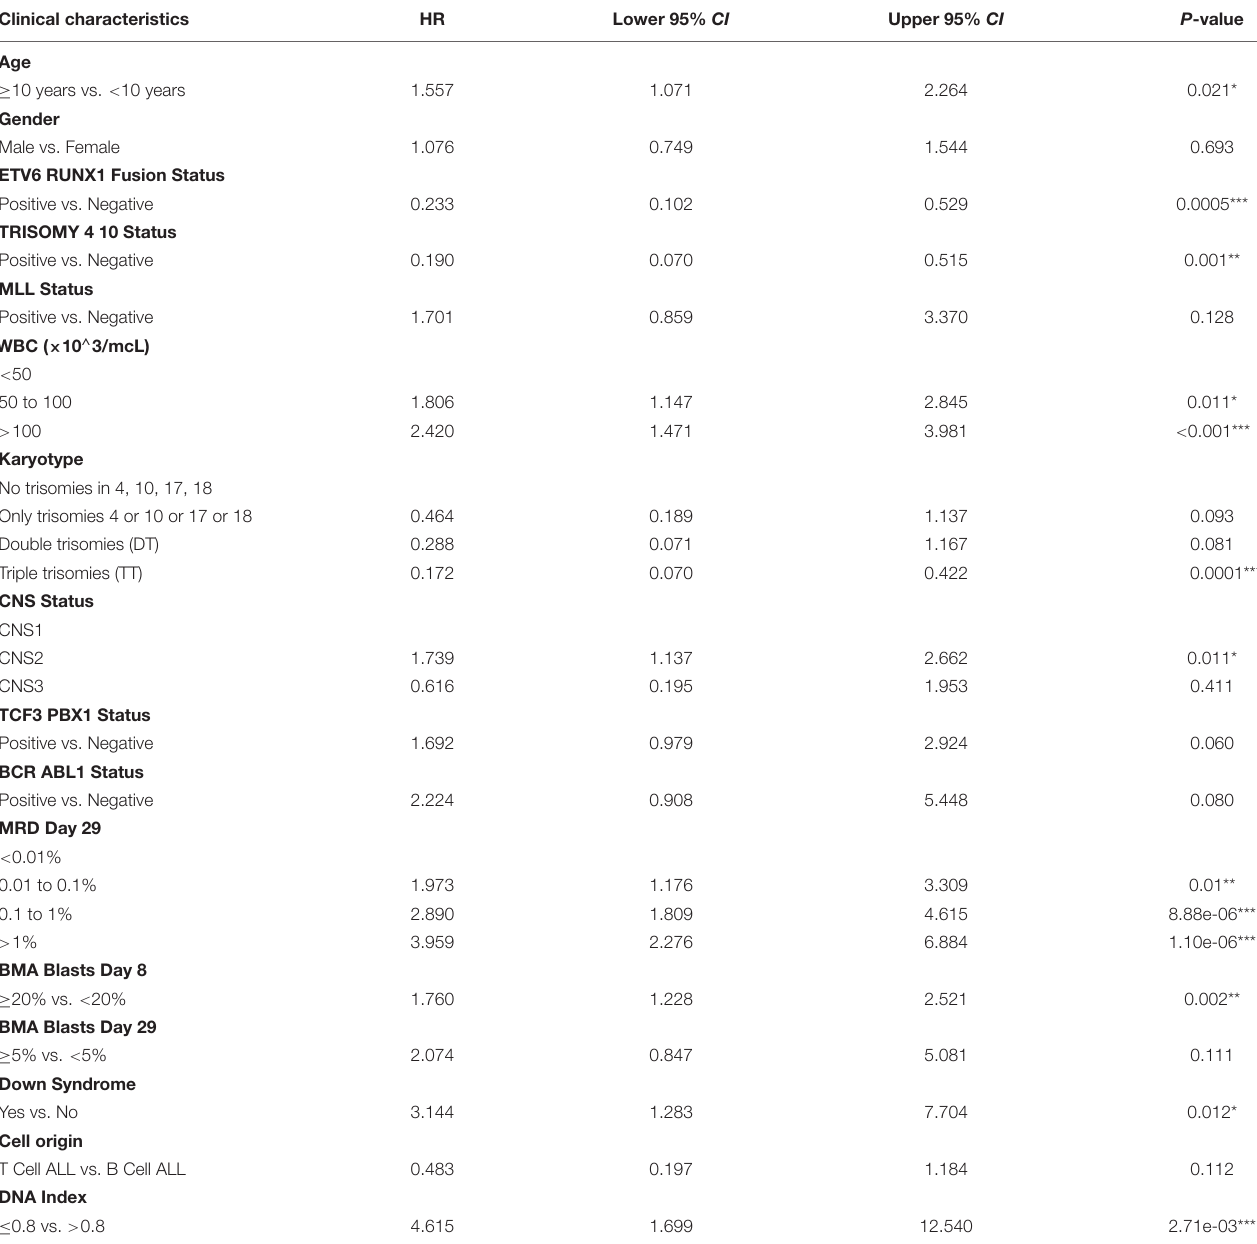
TABLE 2 | The results of univariate Cox analysis. Clinical